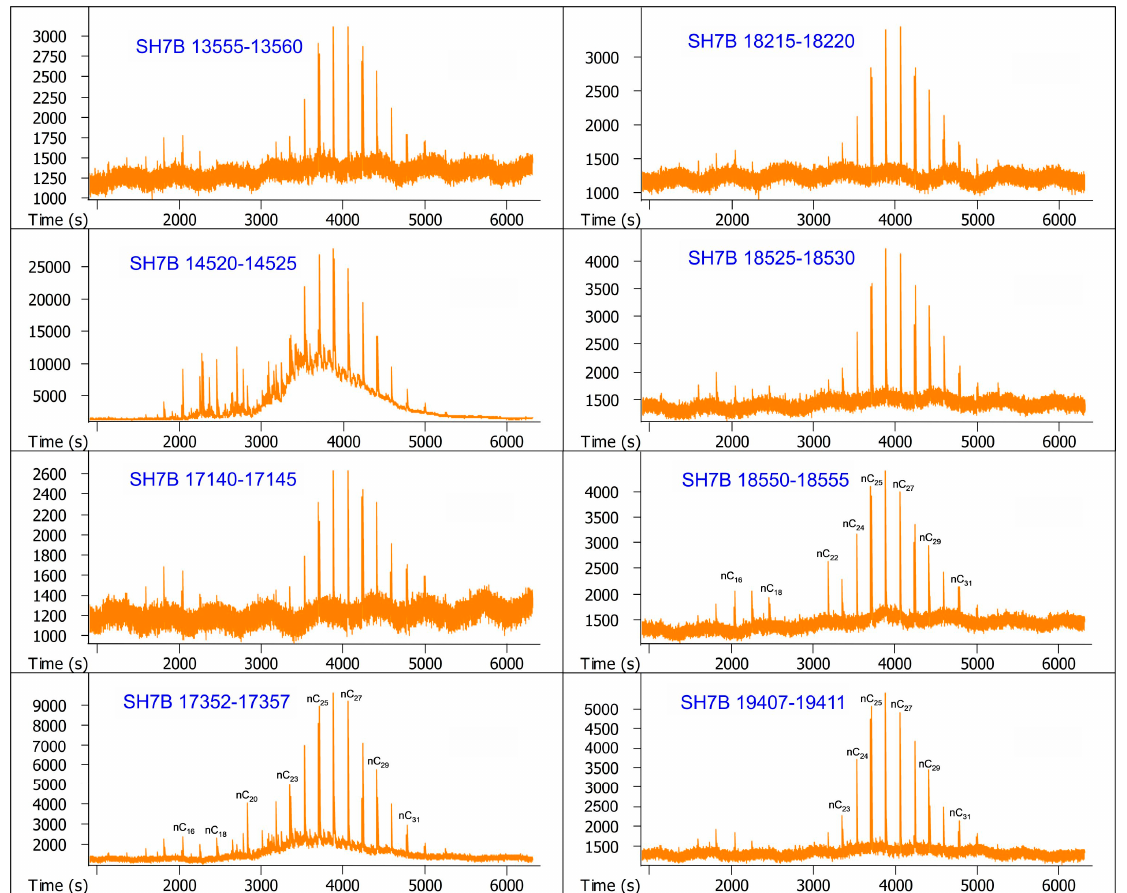
Figure 3. GC-MS chromatograms of the saturated hydrocarbon fractions from sediment core SH7B. The numbers above the main peaks indicate the carbon atom numbers of n -alkanes. Pr and Ph indicate pristane and phytane, respectively.